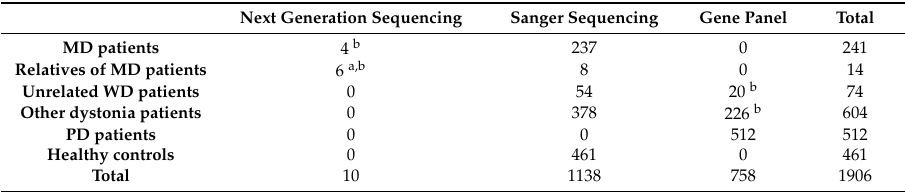
Table 1. Overview of the sequenced patient and control cohorts.